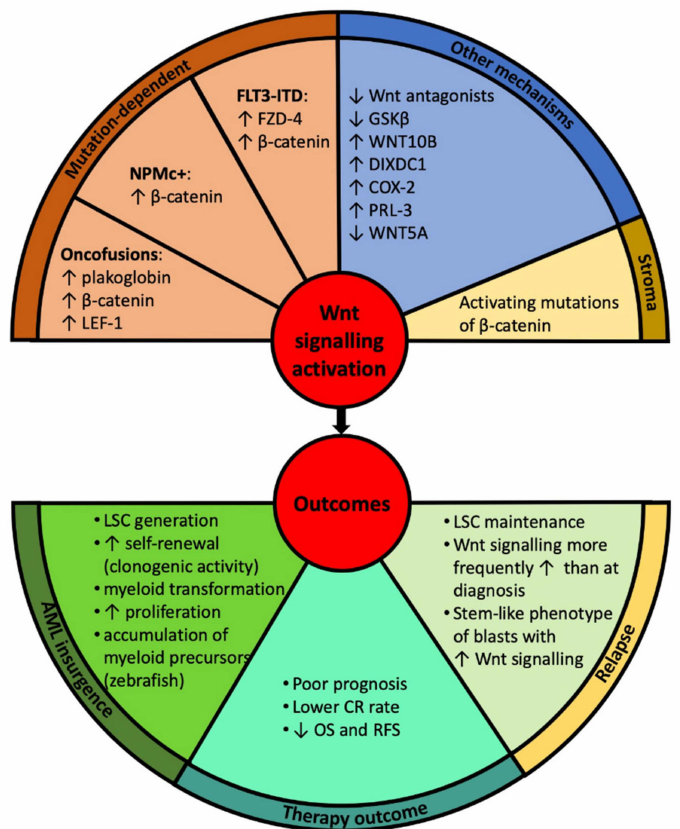
Figure 2. Mechanisms activating Wnt signalling in acute myeloid leukaemia (AML) and their consequences for the disease